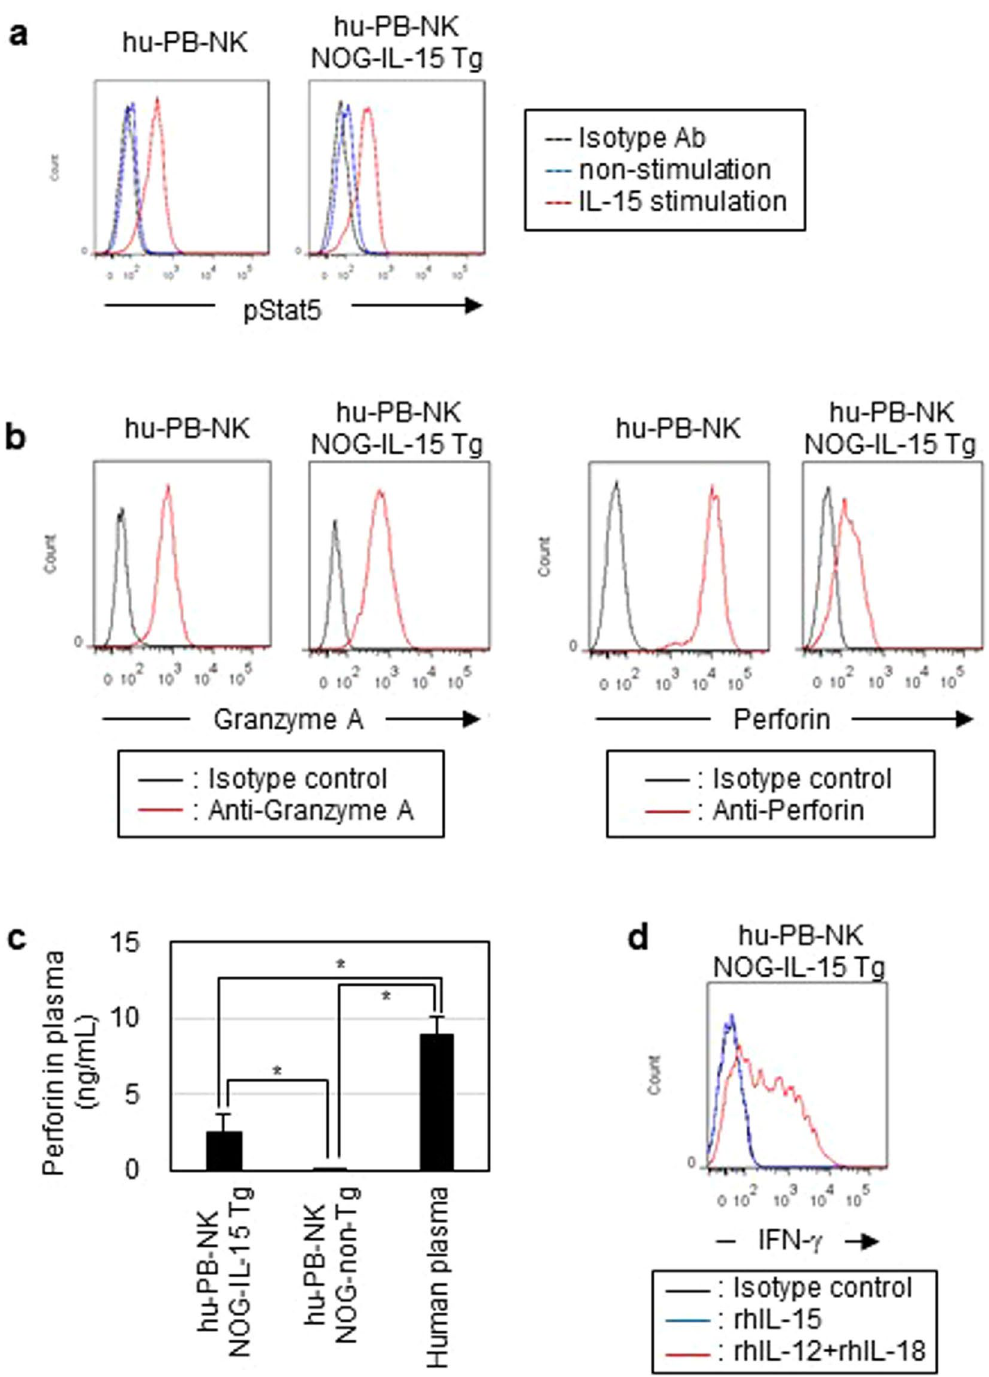
Figure 5. Analysis of functions in in vivo -expanded human PB-NK cells. ( a ) Phosphorylation of STAT5. Freshly isolated hu-PB-NK cells and NK cells in NOG-IL-15 Tg mice at 6 weeks after transfer were stimulated with recombinant human IL-15 (2 ng/ml) for 30 min at 37 °C. The cells were analyzed by phosflow. ( b ) Production of granzyme A and perforin molecules. The cells were cultured in the presence of 3 μ g/ml breferdin A for 20 h at 37 °C, and subsequently fixed, permeabilized, and stained with indicated antibodies specific for granzyme A or perforin. The fresh PB-NK cells and in vivo -expanded NK cells in NOG-IL-15 Tg mice were derived from different donors. ( c ) Quantitation of human perforin in plasma. Plasma was prepared from the PB of NOG-non-Tg (n = 12) or NOG-IL-15 Tg (n = 15) mice at 6 weeks after transfer of hu-PB-NK cells. The plasma from normal human donors (n = 5) was used as a control. Perforin levels were determined by ELISA. The p-value was obtained using Student’s t -test ( * p < 0.01). ( d ) IFN- γ production of in vivo -expanded